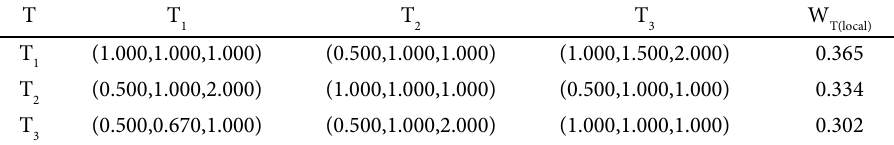
Table 10. Pair-wise comparison matrices and local weights for “T”-group factors